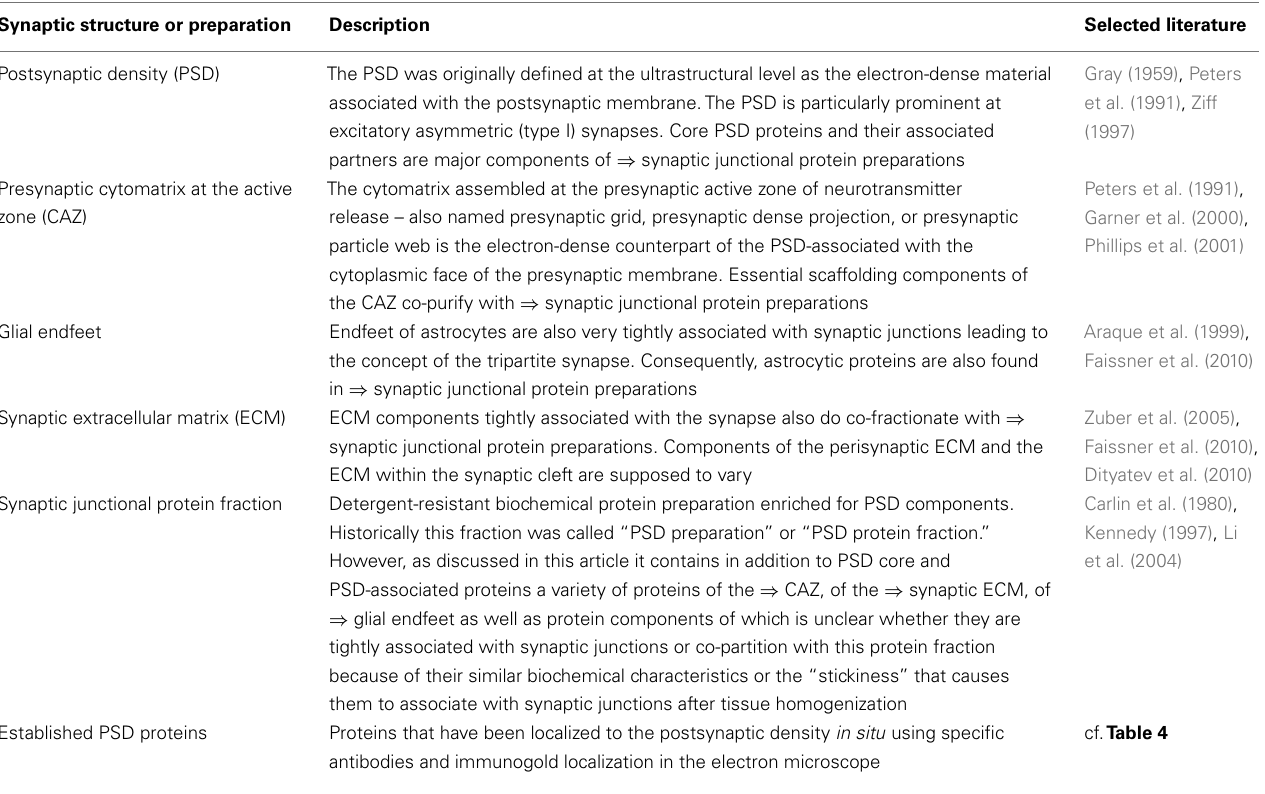
Table 1 | Glossary of subsynaptic structures and protein